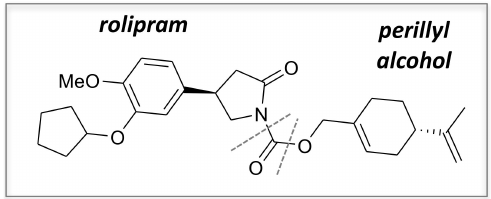
Figure 1. Chemical structure of NEO214. NEO214 was generated by covalently linking rolipram to perillyl alcohol via a carbamate bridge (shown between dotted